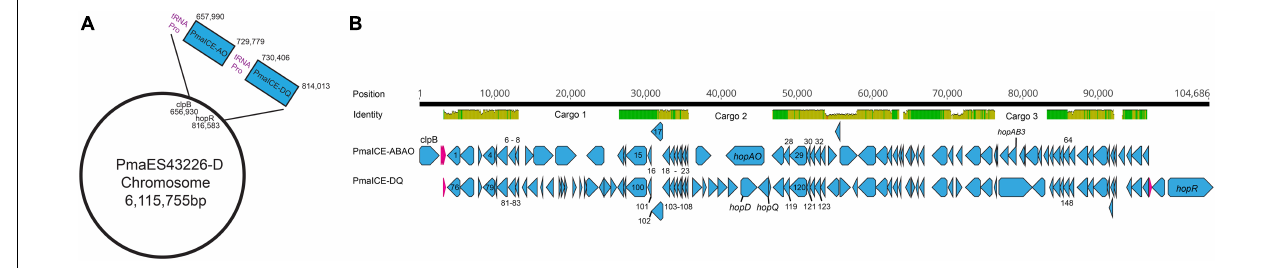
FIGURE 1 | Comparison of PmaICE-ABAO and PmaICE-DQ. (A) A representation of the circular chromosome of strain Pma ES4326-D, highlighting the region where both ICE elements are found as well as the tRNA-Pro loci that border these ICE elements. (B) We aligned nucleotide sequences from the pair of potential ICEs found within the clpB-hopR region in strain Pma ES4326 against each other, and visualize the results here. The top line of the figure displays overall nucleotide identity between these two ICEs, with green bars representing conserved nucleotides and yellow representing slight to modest divergence. If no colored bars on this top line, the sequences are completely divergent, and we highlight the three potential cargo regions that differ between these ICE elements. Predicted loci for each ICE are shown on the lines immediately below the nucleotide identity comparison. Pma ICE-ABAQ is positioned immediately adjacent to clpB in the Pma ES4326 genome while Pma ICE-DQ is positioned immediately adjacent to hopR in the same genome. Each predicted locus is represented in the figure in blue, while predicted tRNA loci are represented in magenta. We labeled all identified type III effector loci within these regions as well as clpB . All loci that are implicated in ICE function, by annotation, have been labeled with numbers that correspond to their annotations within Table 3